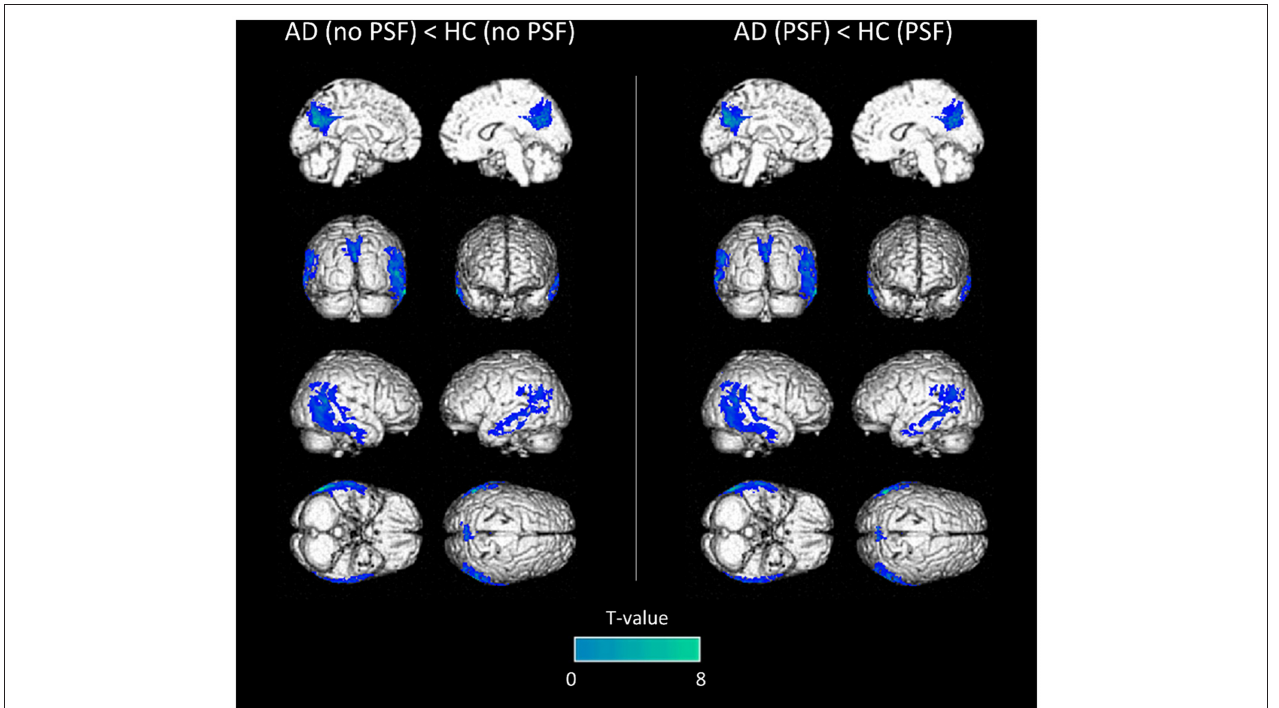
FIGURE 2 | Anatomical localization of areas of decreased metabolic activity in AD patients compared to controls ( p < 0.001, uncorrected, k > 1.5 cm 3 ) from PET images without PSF deconvolution (left panel) or with (right panel), projected onto 3D volume rendering, spatially normalized and smoothed into the Montreal National Institute (MNI) space.